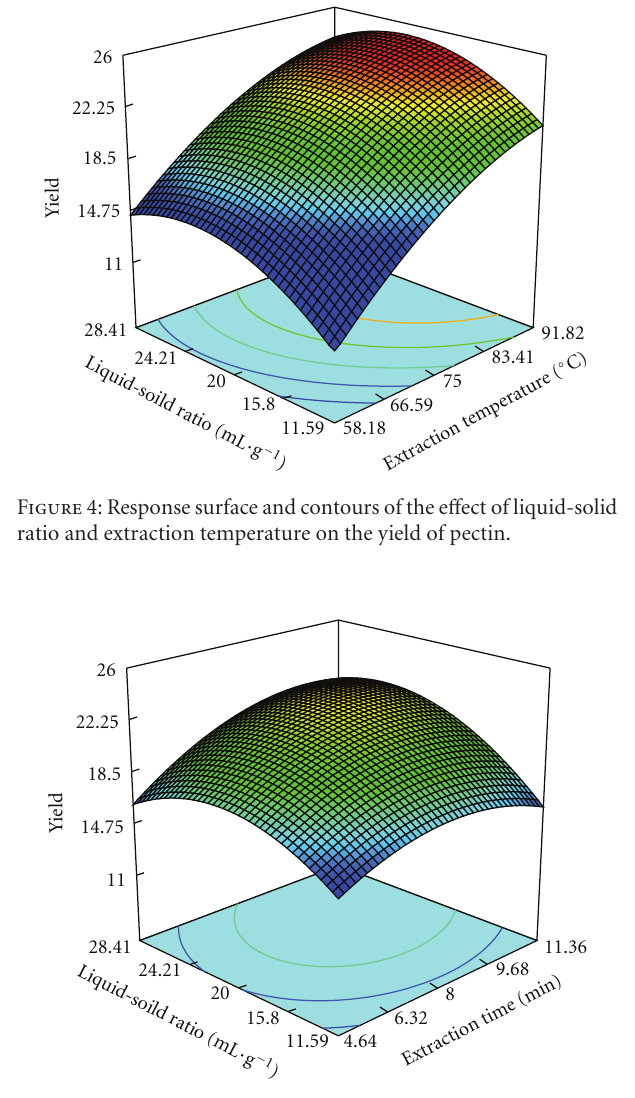
Figure 5: Response surface and contours of the e ff ect of liquid-solid ratio and extraction time on the yield of